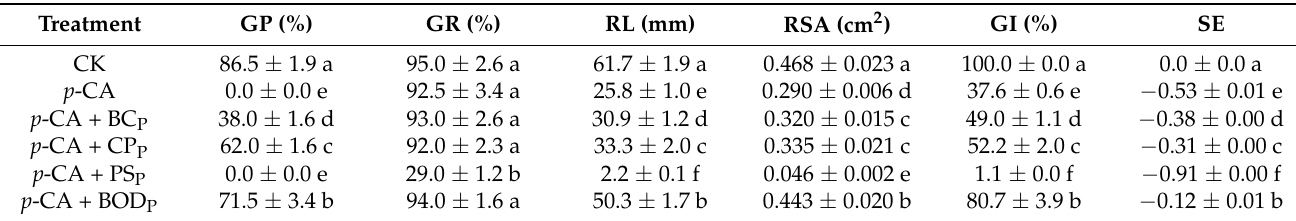
Table 1. Effects of different treatments on tomato seed germination